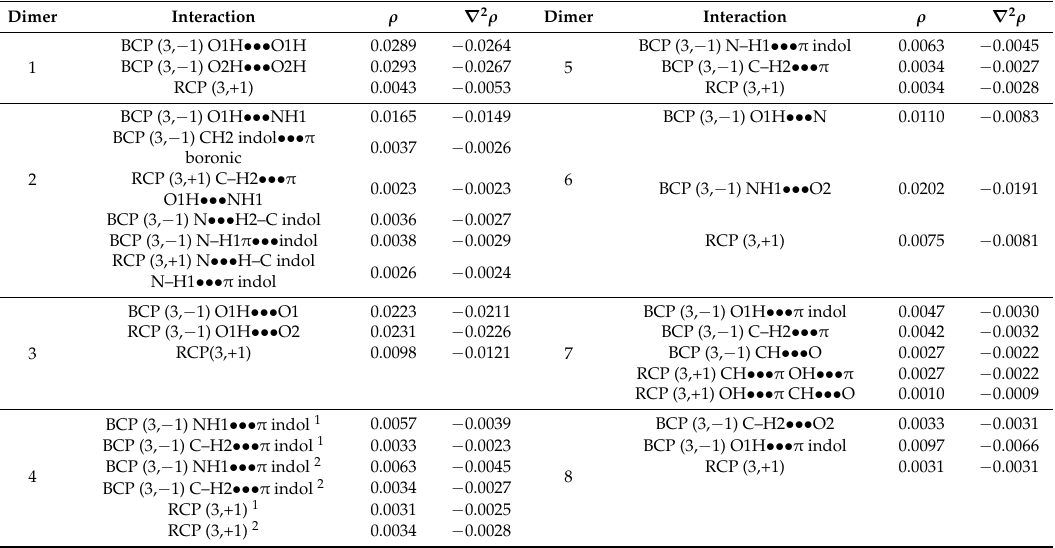
ρ = electron density (e/a.u. 3 ); ∇ 2 ρ = Laplacian of density; 1 and 2 Indole ring of indolylic moiety.